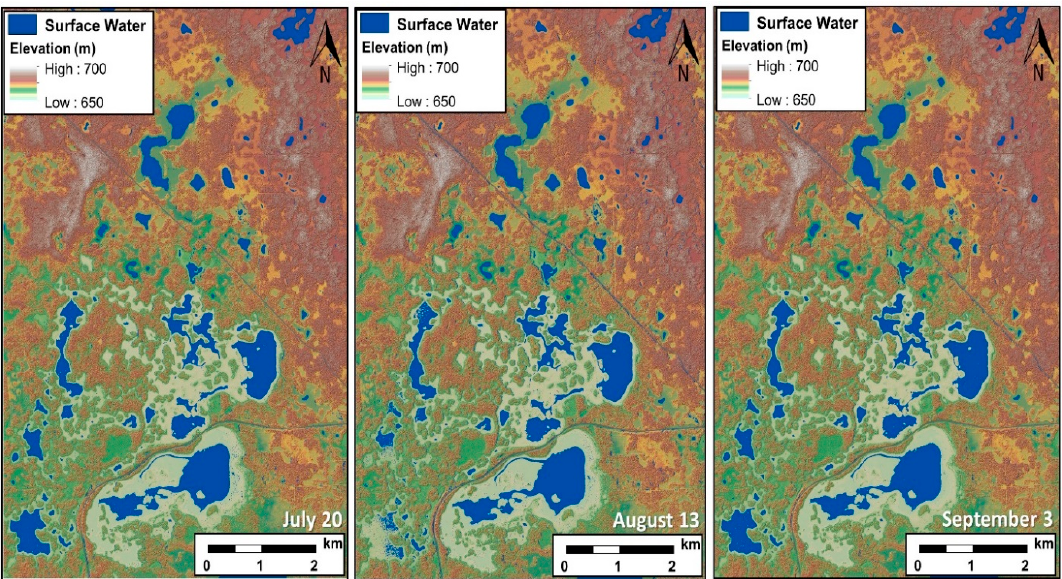
Figure 3. Intensity threshold (dB) SAR-derived surface water masks over the URSA region in the growing season of 2015. Images show relatively consistent surface water extent.